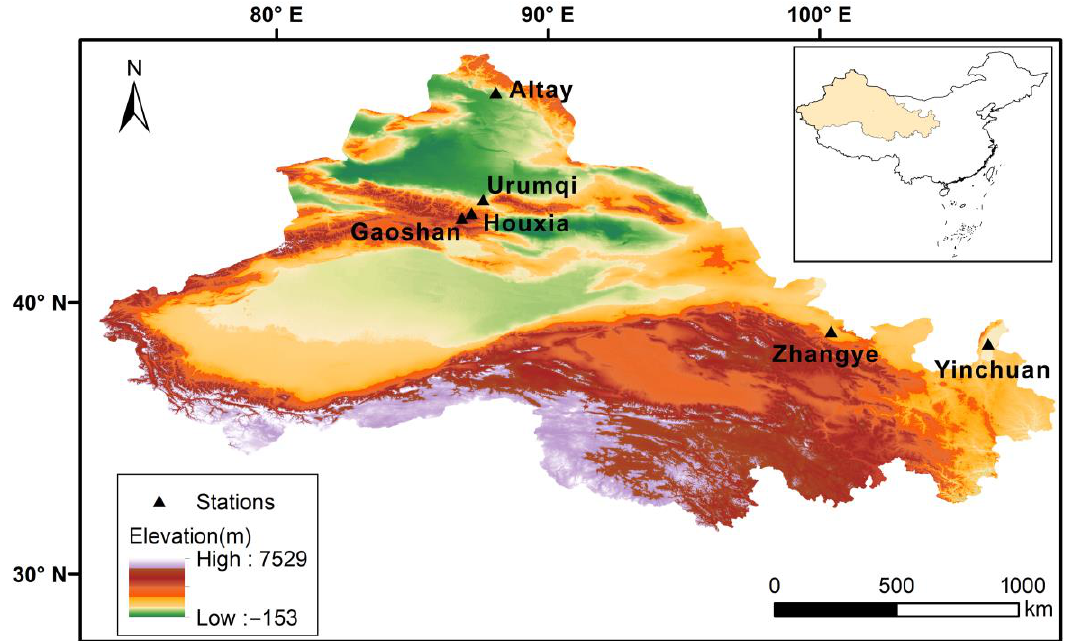
Figure 1. Study area and selected stations of precipitation isotopes monitoring across Northwest China.